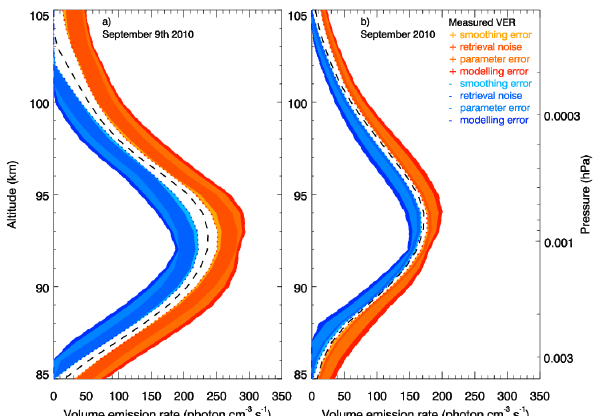
Figure 6. Sample daily (a) and monthly (b) averaged green line VER profiles for the 20–25 ◦ N latitude range with uncertainty ( σ S ) components σ S (yellow), σ S (light red), σ S (orange), σ S tot s m b f (red) introduced and calculated for the V ER + 1 retrieval, σ S (cyan s marked), σ S (light blue), σ S (dark cyan) and σ S (blue) intro- m b f duced and calculated for the V ER − 1 retrieval. See Sects. 4, 4.3, 6.1 and 7.1 for further